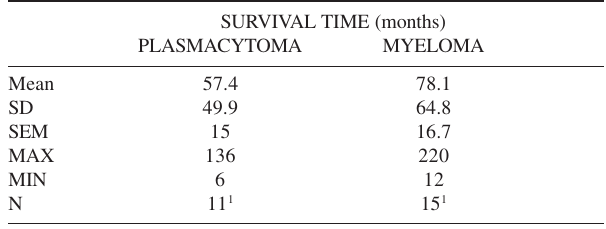
Table 5 - Survival time (in months) in patients with plasmacytoma vs patients with plasmacytoma that progressed to multiple myeloma